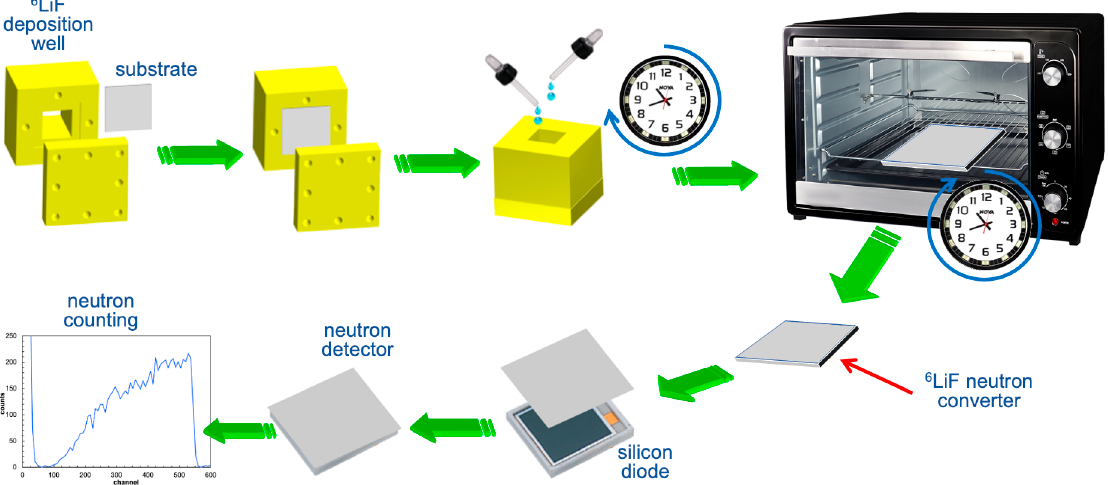
Figure 15. Pictorial scheme summarizing the phases of the chemical deposition technique for the production of a 6 LiF neutron converter layer onto a suitable